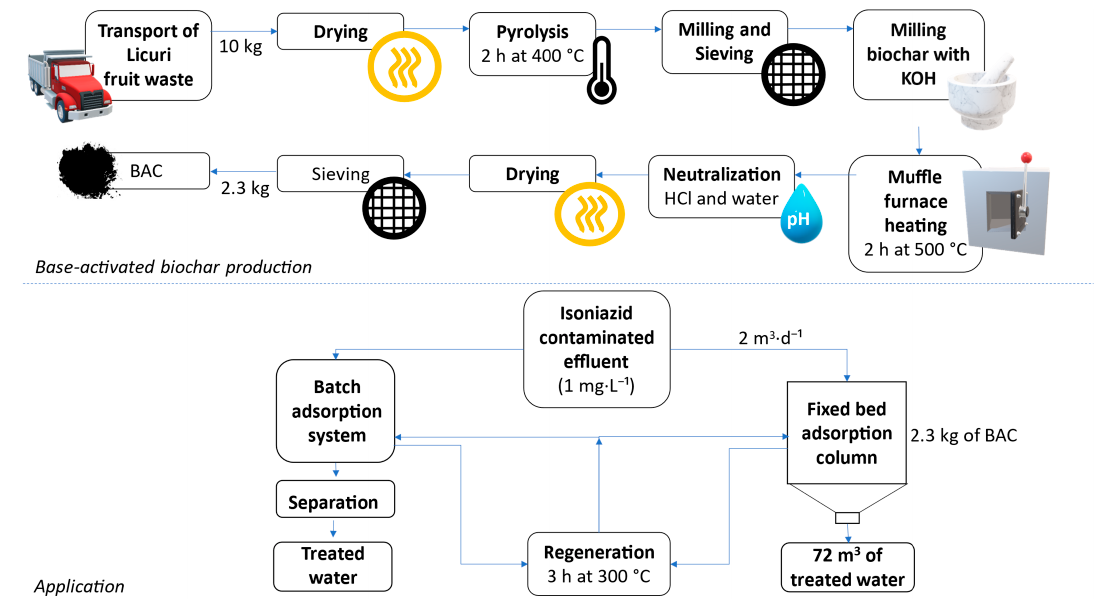
Figure 7. Potential applicability of